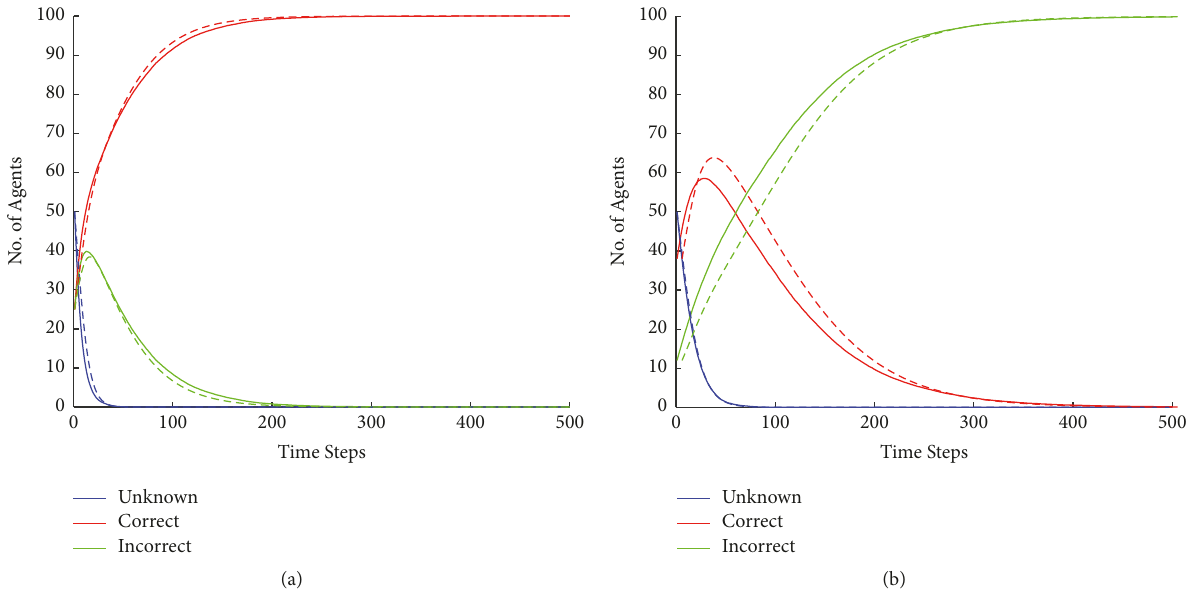
Figure 5: Results against almost homogenous populations for both scenarios. (a) HMM case against “nominal scenario”; (b) HHM case against “wishful-thinking scenario.”